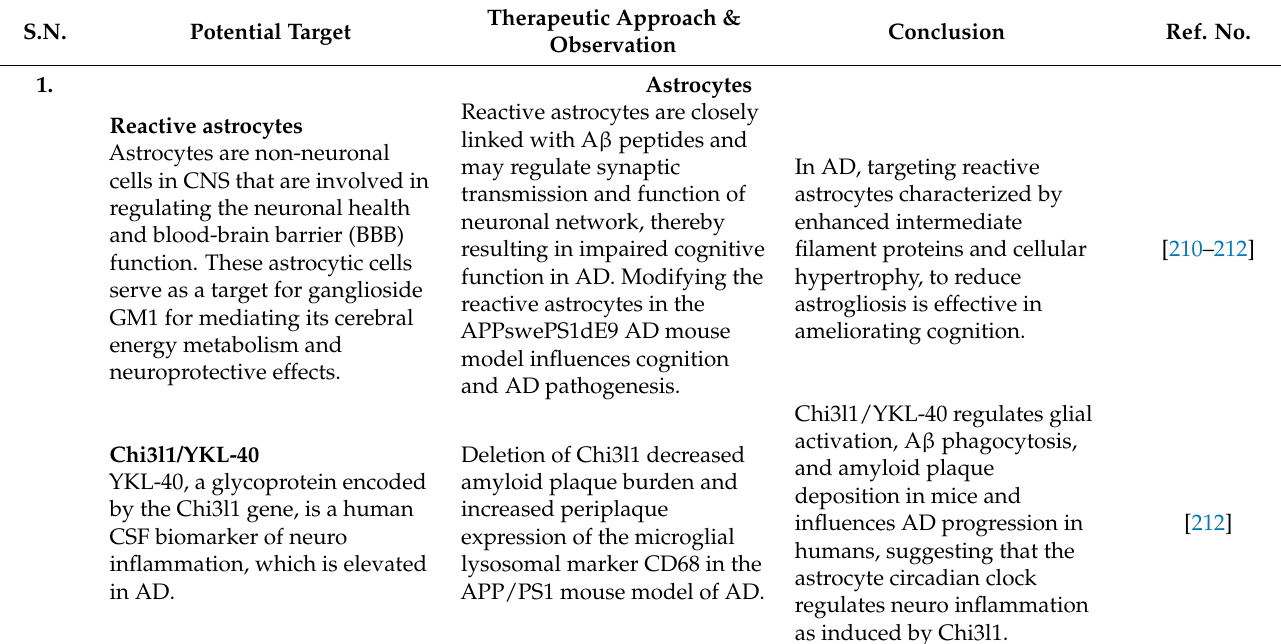
Table 1. Promising therapeutic targets for ameliorating